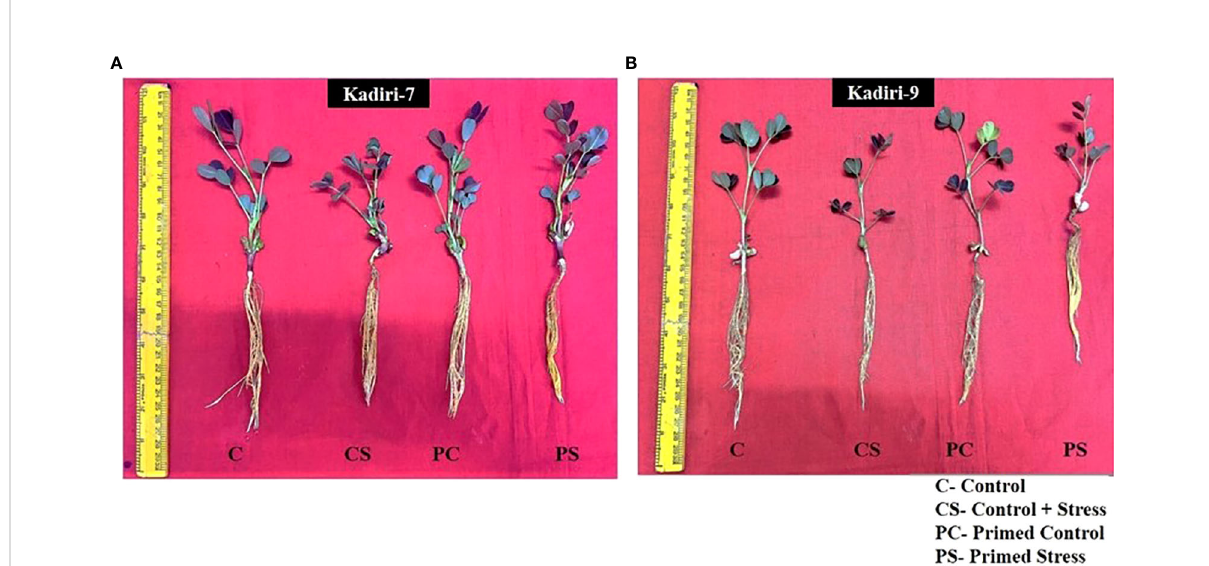
FIGURE 1 Phenotypic changes of melatonin-primed and unprimed plants of drought-sensitive (K-7) and drought-tolerant (K-9) varieties of groundnut ( Arachis hypogaea L.) under optimal conditions and PEG-6000 (10%) induced drought stress. C- Plants grown under optimal conditions in Hoagland ’ s nutrient (0.5X) solution (control); CS- Plants grown by adding PEG in Hoagland ’ s nutrient (0.5X) solution for 4 days (drought- stressed); PC- Melatonin primed plants grown under optimal conditions in Hoagland ’ s nutrient (0.5X) solution (primed control); PS - Melatonin primed plants grown by adding 10% PEG-6000 in Hoagland ’ s nutrient (0.5X) solution for 4 days (primed stress). (A) Drought-sensitive variety, Kadiri-7 (K-7); (B) Drought-tolerant variety, Kadiri-9